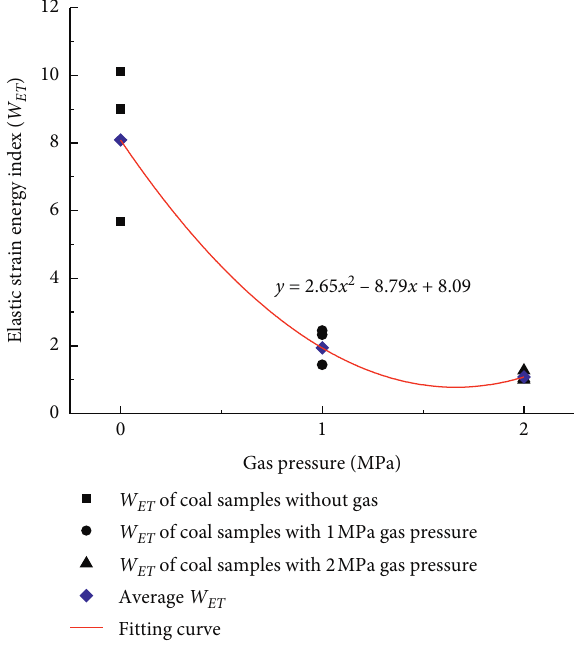
Figure 10: Relation curve between W